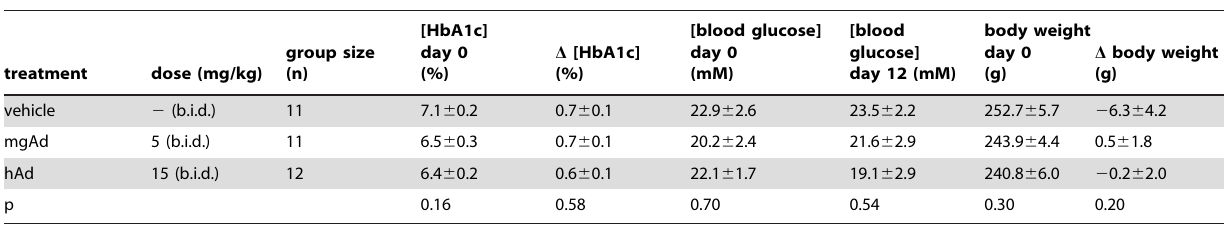
Table 3. Data from diabetic Psammomys obesus study (mean 6 SEM).